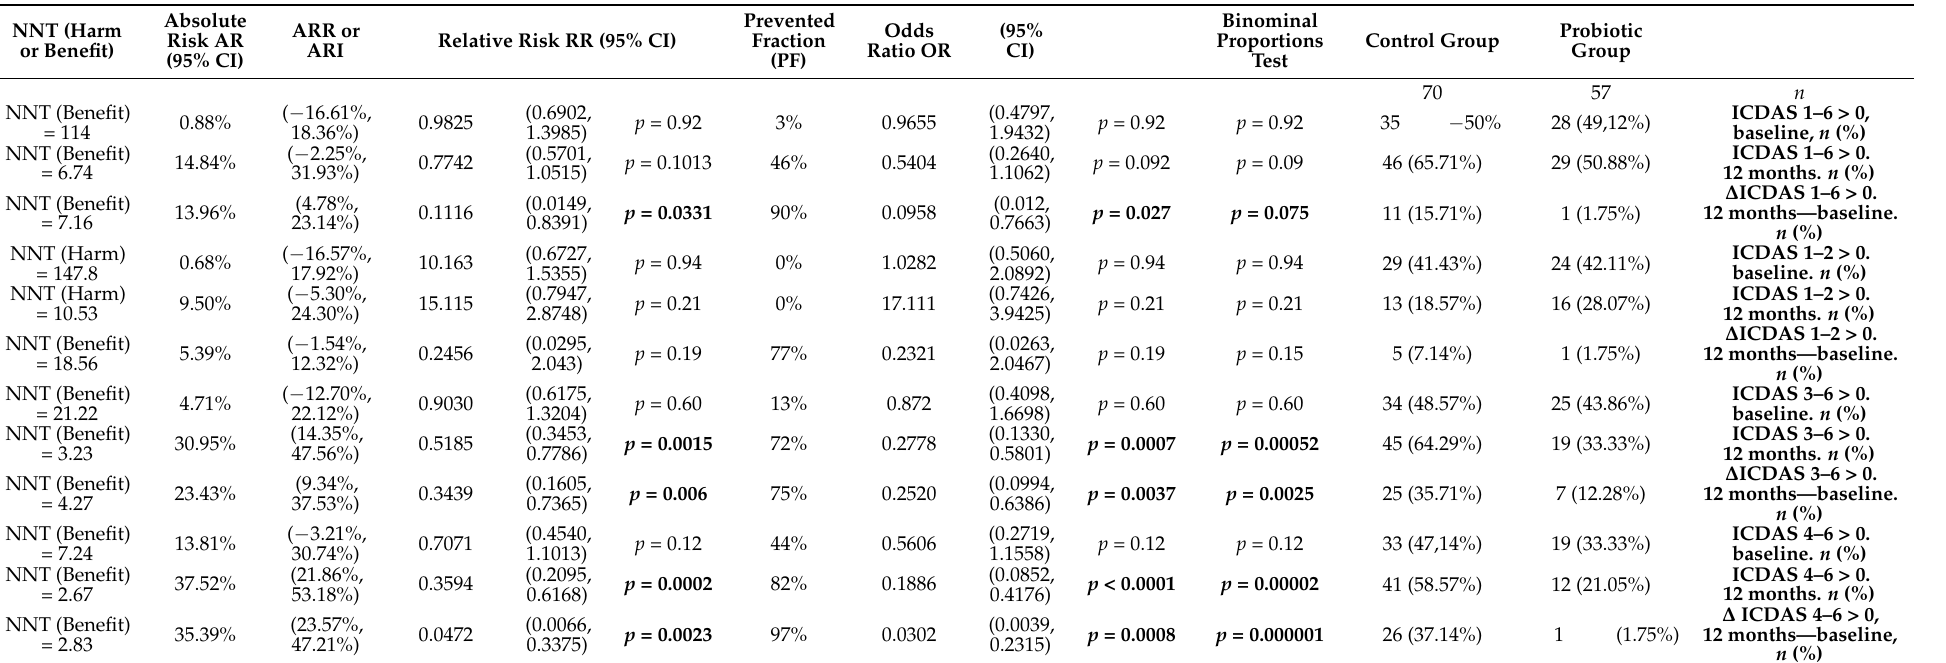
Table 3. Dental caries prevalence in the probiotic and control group at baseline and end of the